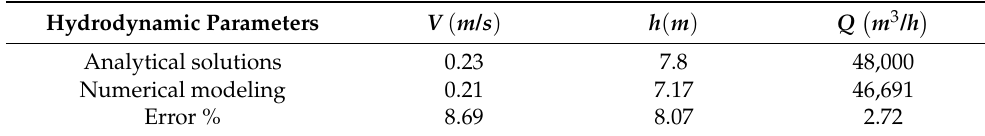
Table 1. Comparison of validation and accuracy results and numerical model calibration for hydro- dynamic